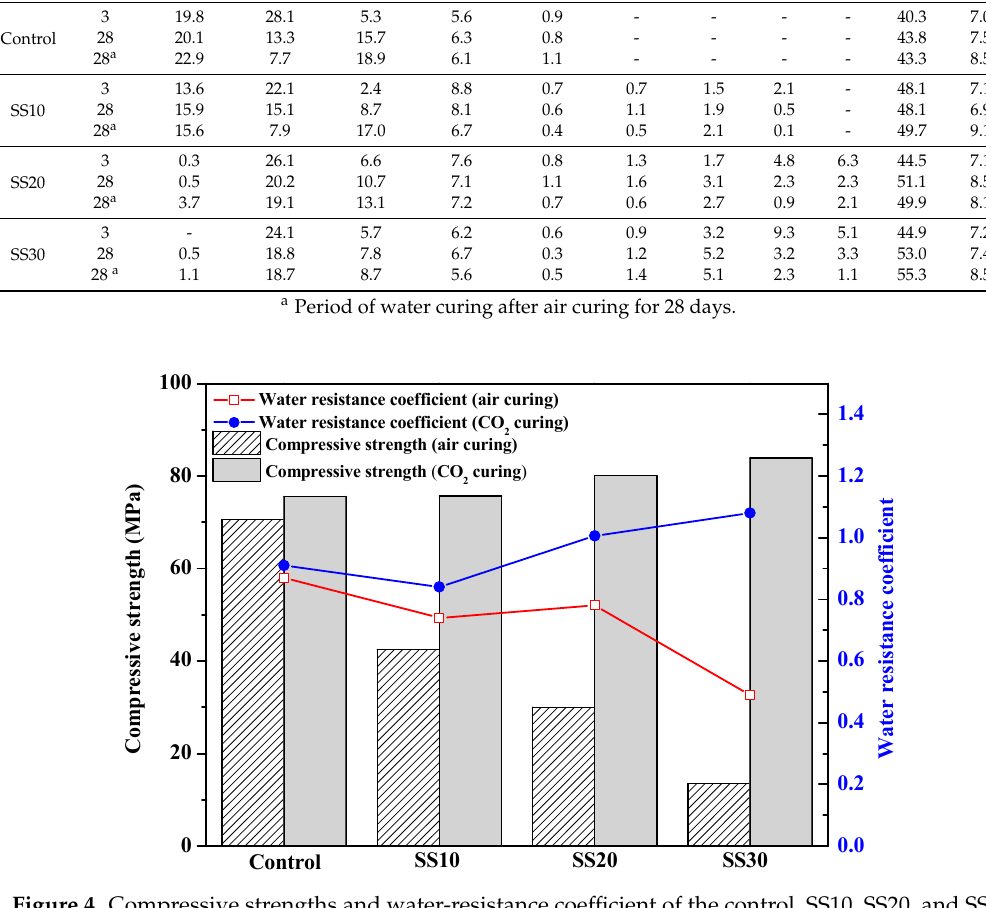
Figure 3. Compressive strengths of the control, SS10, SS20, SS30, SS40, and SS60 with CO 2 treatment at 3 days, 7 days, and 28 days.